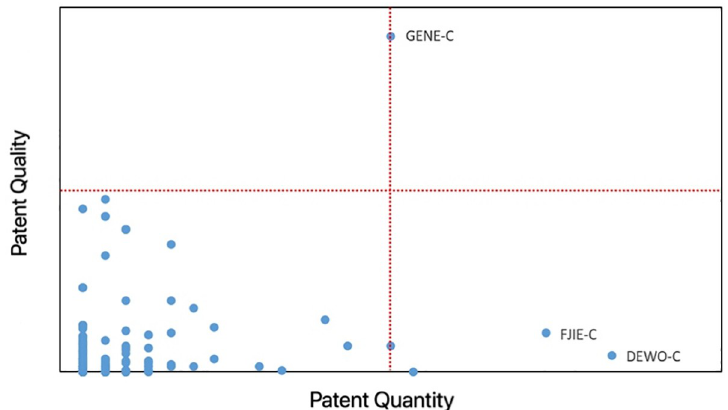
Fig 4. Scatter plot of the total number of patents and the total number of citations at the institution level.